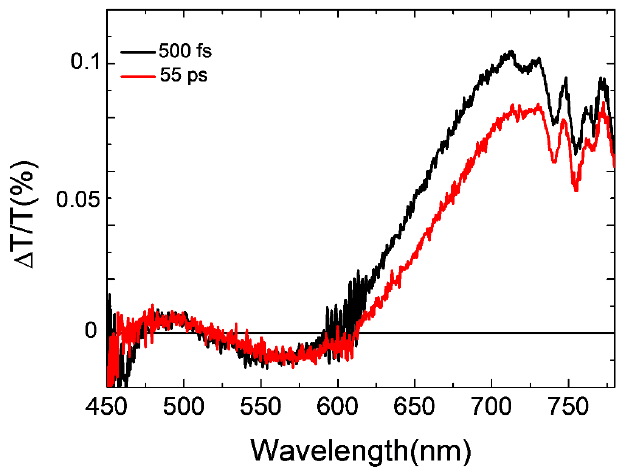
Figure 6. Pump and probe spectra at different probe delays for the BPC5